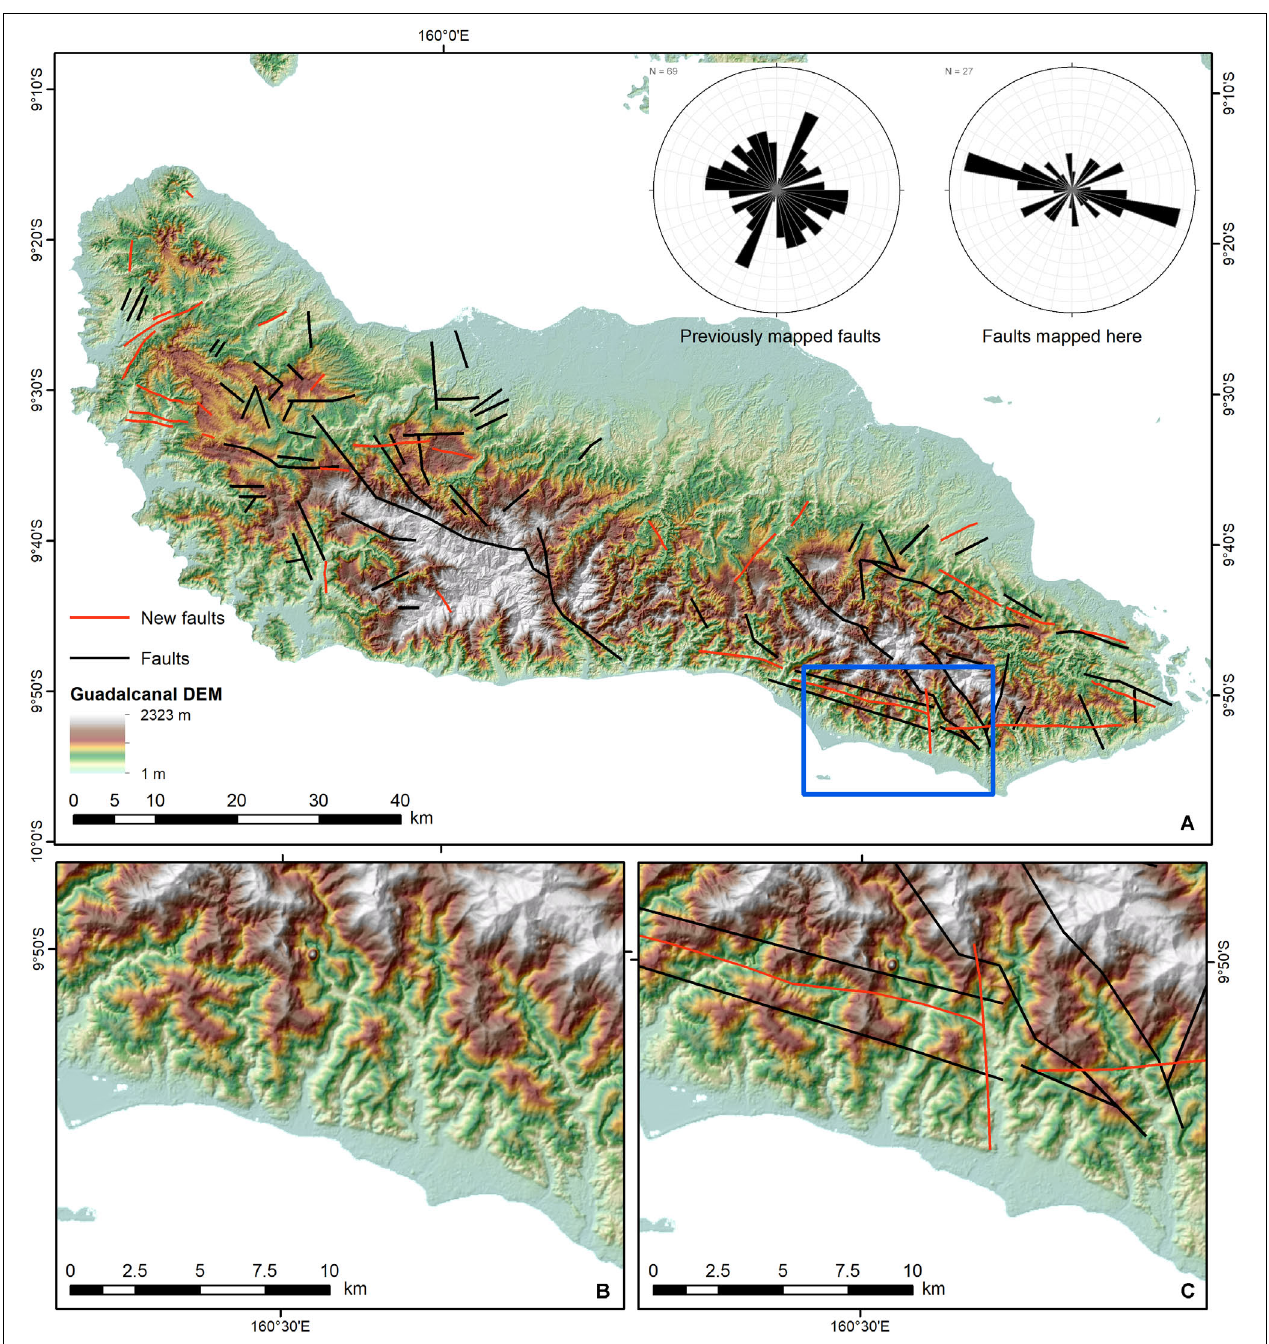
FIGURE 4 | (A) ALOS World 3D 30 m DEM (©JAXA) of Guadalcanal showing existing faults from the published mapping data (Department of Geological Surveys, 1969) and inferred topographic lineaments, rose diagrams showing the orientations of both datasets are shown in the top right corner. (B,C) Raw and interpreted DEM for the area shown in the blue box on part (A)